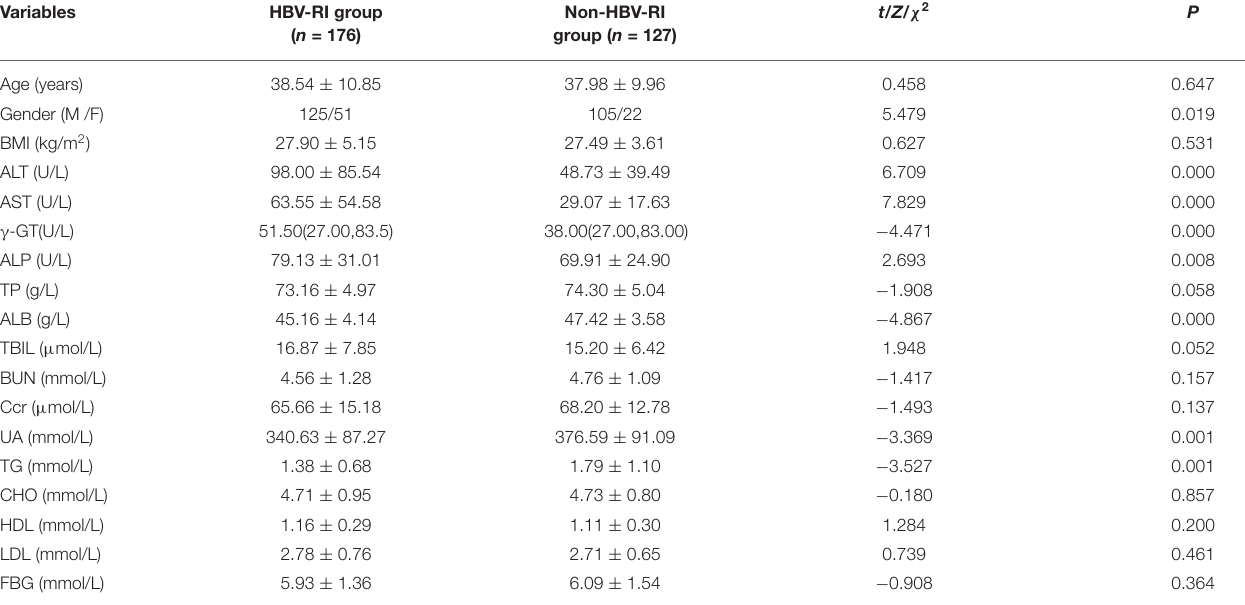
TABLE 1 | Demographic and biochemical data between the HBV-RI group and the non-HBV-RI group.